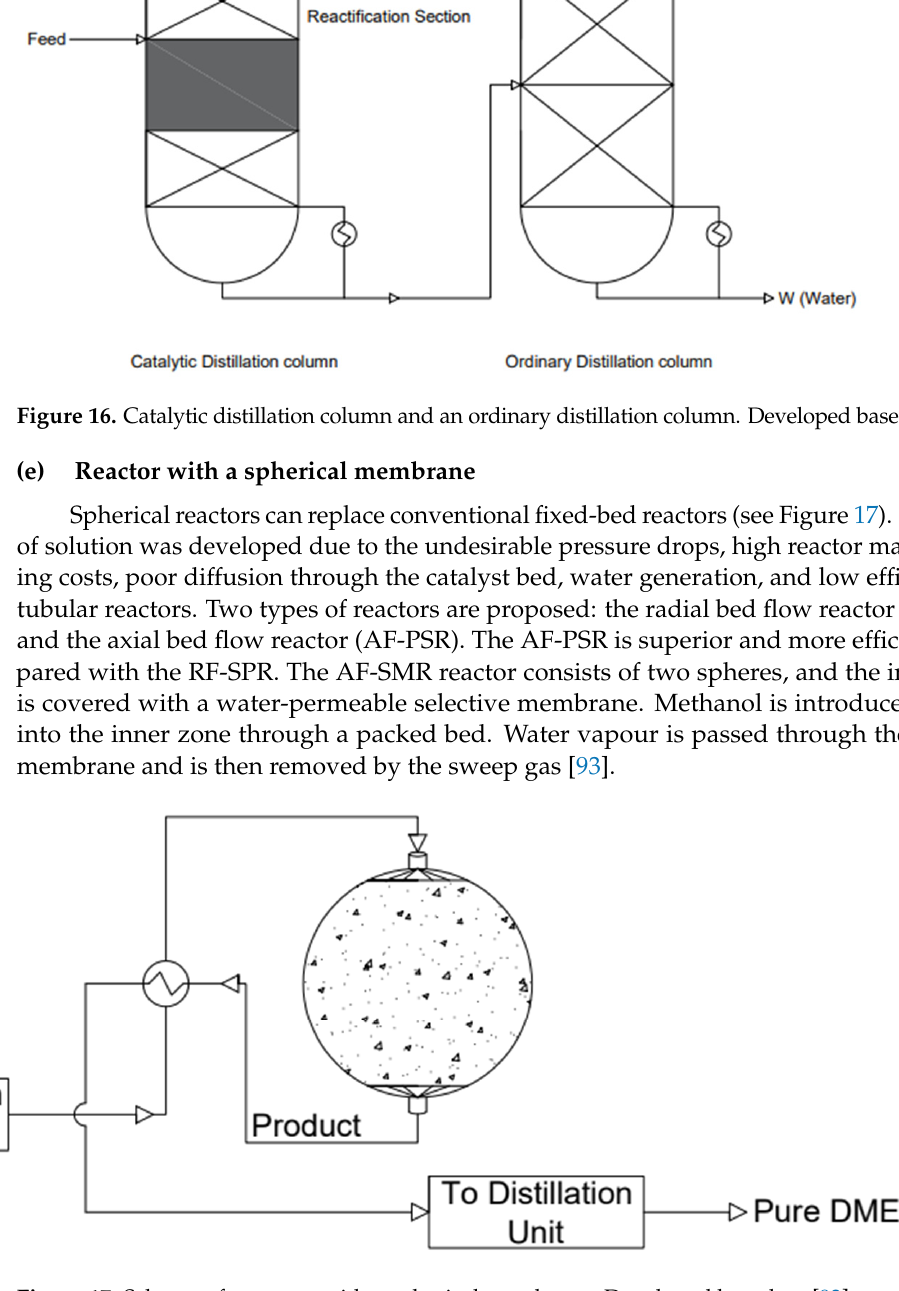
baffle column (DWC), which replaces the direct distillation sequence. This solution saves energy by 12–58% and reduces CO 2 emissions by about 60%; the operating costs alone are reduced by about 30% [101,128].